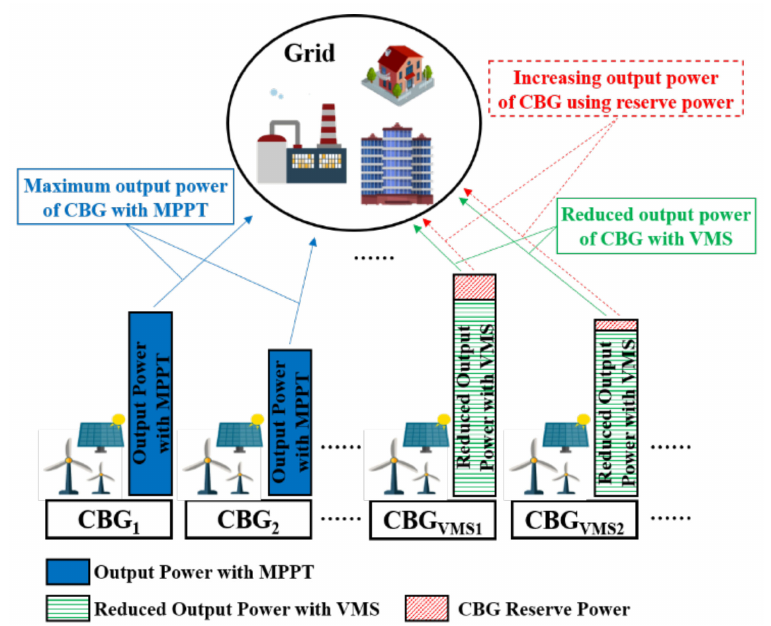
Figure 2. Power system based on the proposed VMS power system including CBGs with power